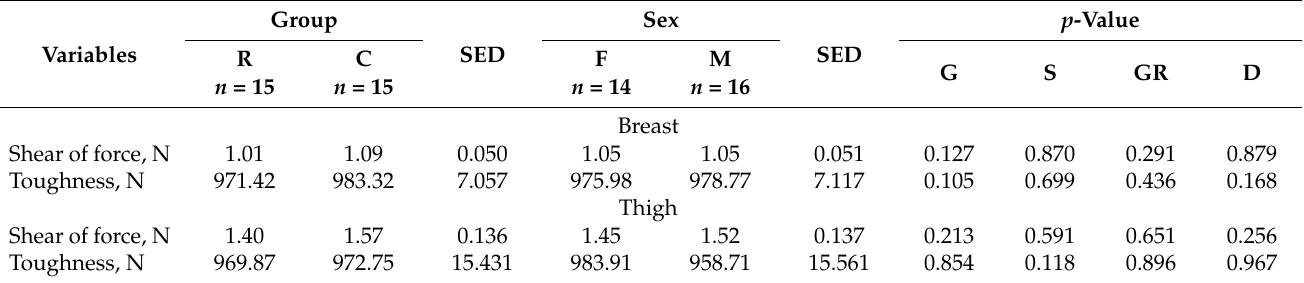
Table 5. Effects of diet and sex on Warner–Bratzler test parameters on goose